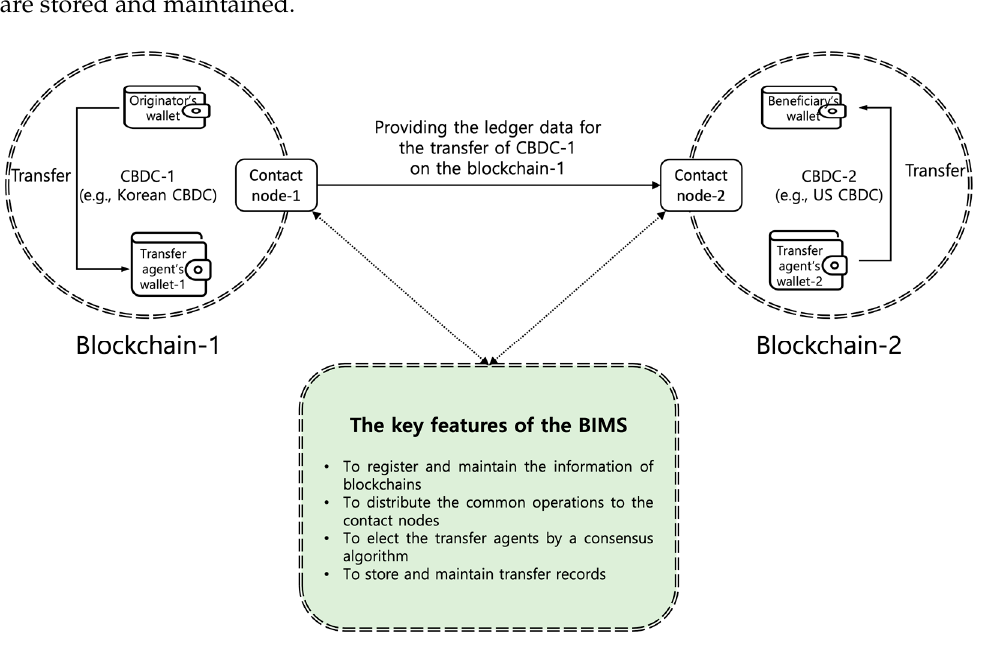
Figure 5. The service model for the transfer between CBDC-1 and CBDC-2.